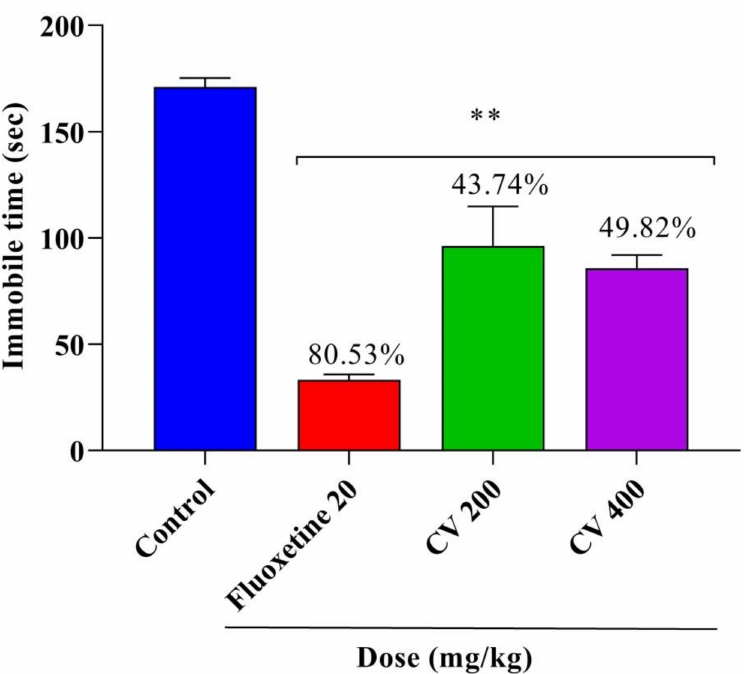
Figure 4. Antidepressant activities of the methanol extract of Cnesmone javanica (CV) and fluoxetine as assessed by the forced swim test. Significant differences (** p < 0.001) were assessed using one-way analysis of variance (ANOVA, followed by Dunnett’s test).